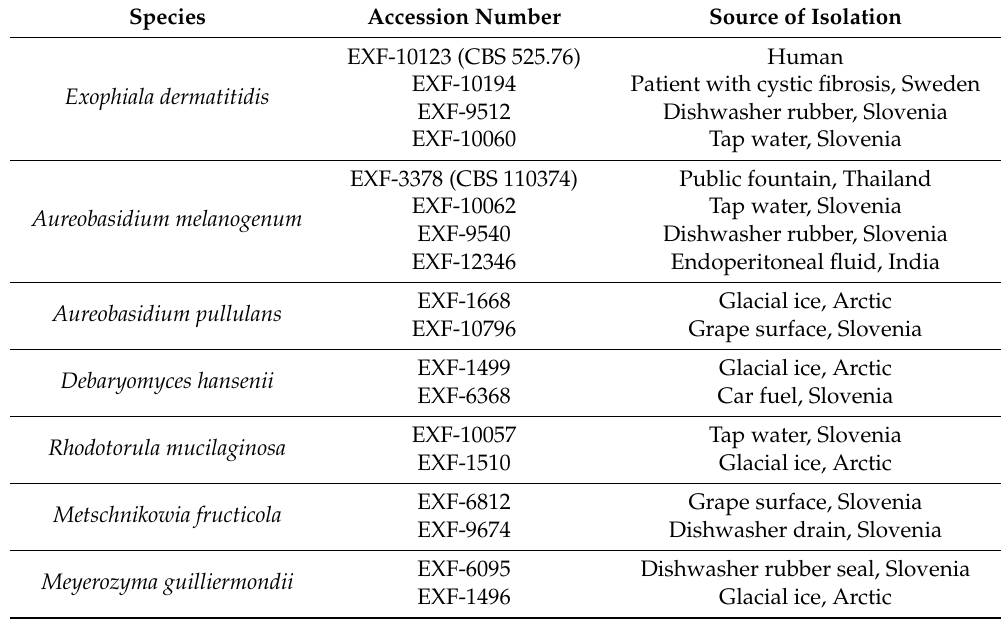
Table 1. Selected yeast strains used in this